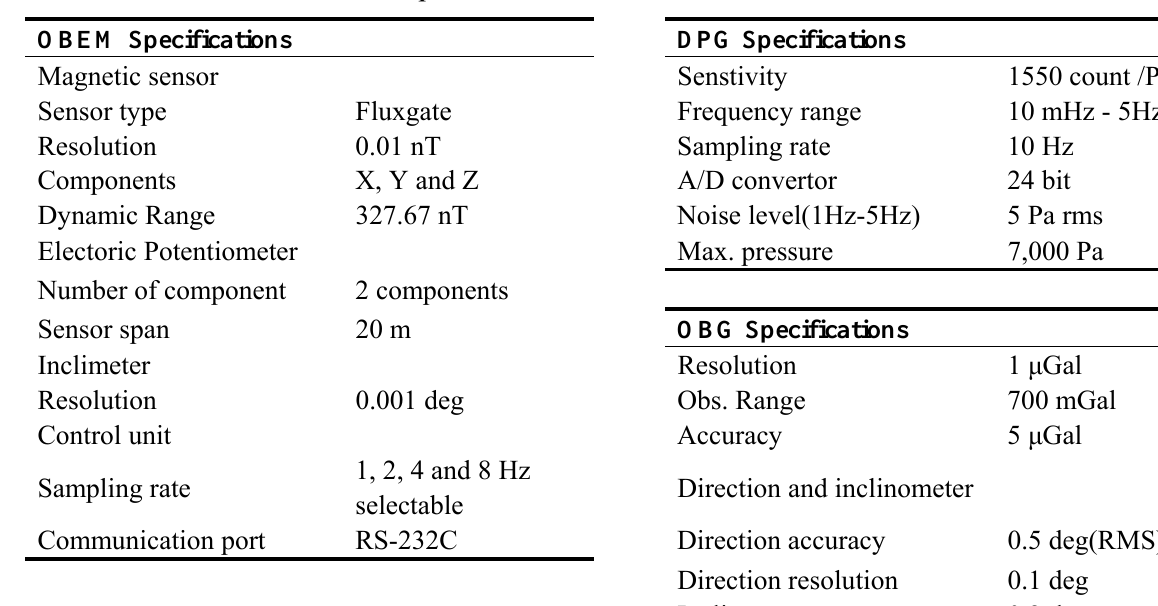
Table 2. Specifications of the OBEM, DPG and